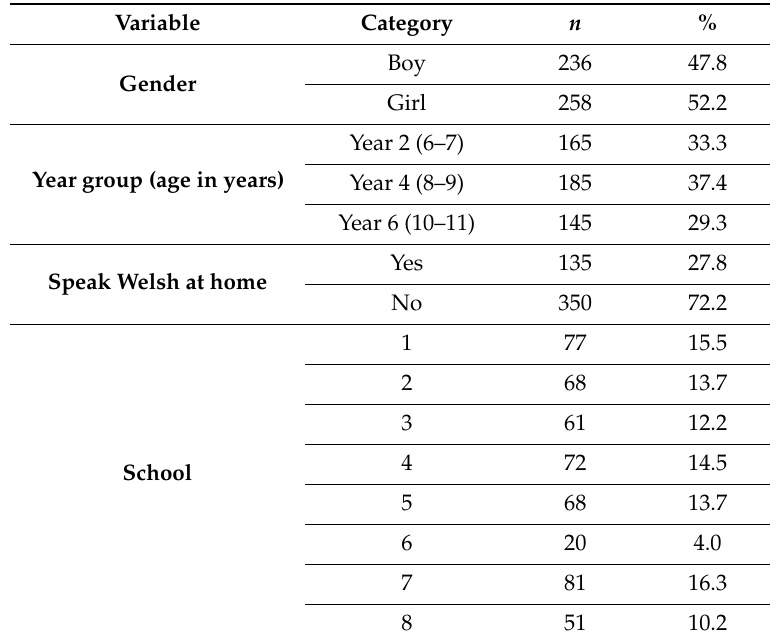
Table 2. Survey findings: children’s knowledge, perceptions and intention to use electronic and tobacco cigarettes ( n = 494). Variable Category %